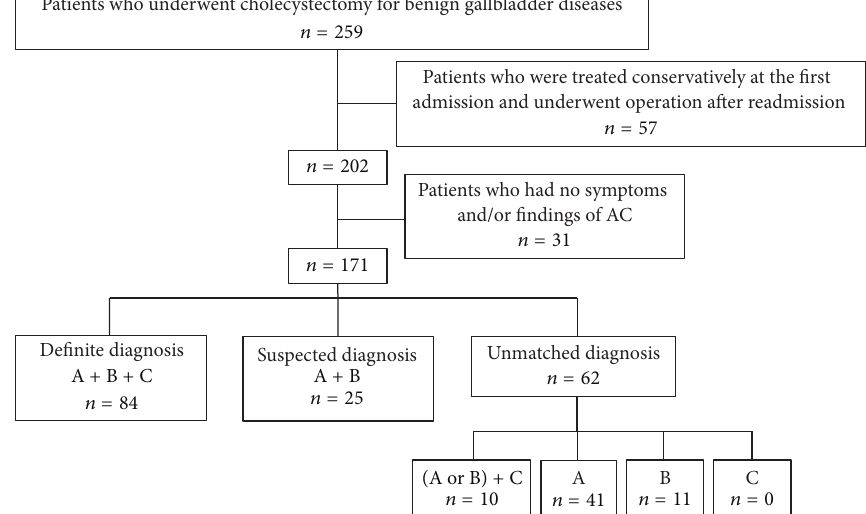
Figure 1: Flow diagram of the 259 patients who underwent cholecystectomy for benign gallbladder diseases according to the diagnostic criteria based on TG13. A, B, and C represent each item in the TG13 diagnostic criteria. AC: acute cholecystitis and TG13: Tokyo Guidelines